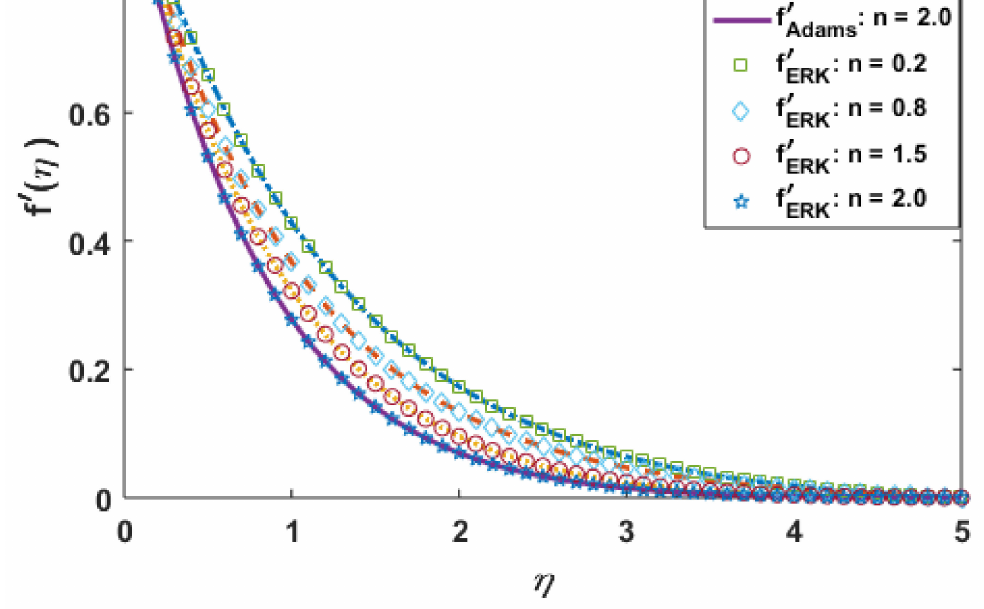
Figure 7. Effects of n on f (cid:48) ( η ) .